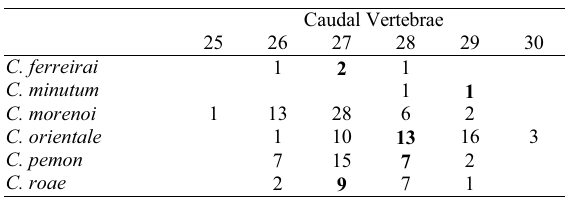
Table 2 . Number of specimens of the species of Cetopsidium with cited number of dorsal and pectoral-fin rays. Bold indicates value for holotype when examined.